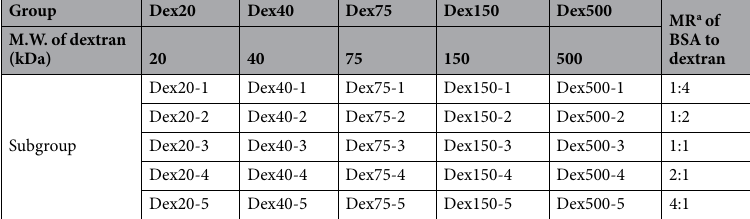
Table 1. Formulations for preparation of Maillard conjugates ( a MR: Molar